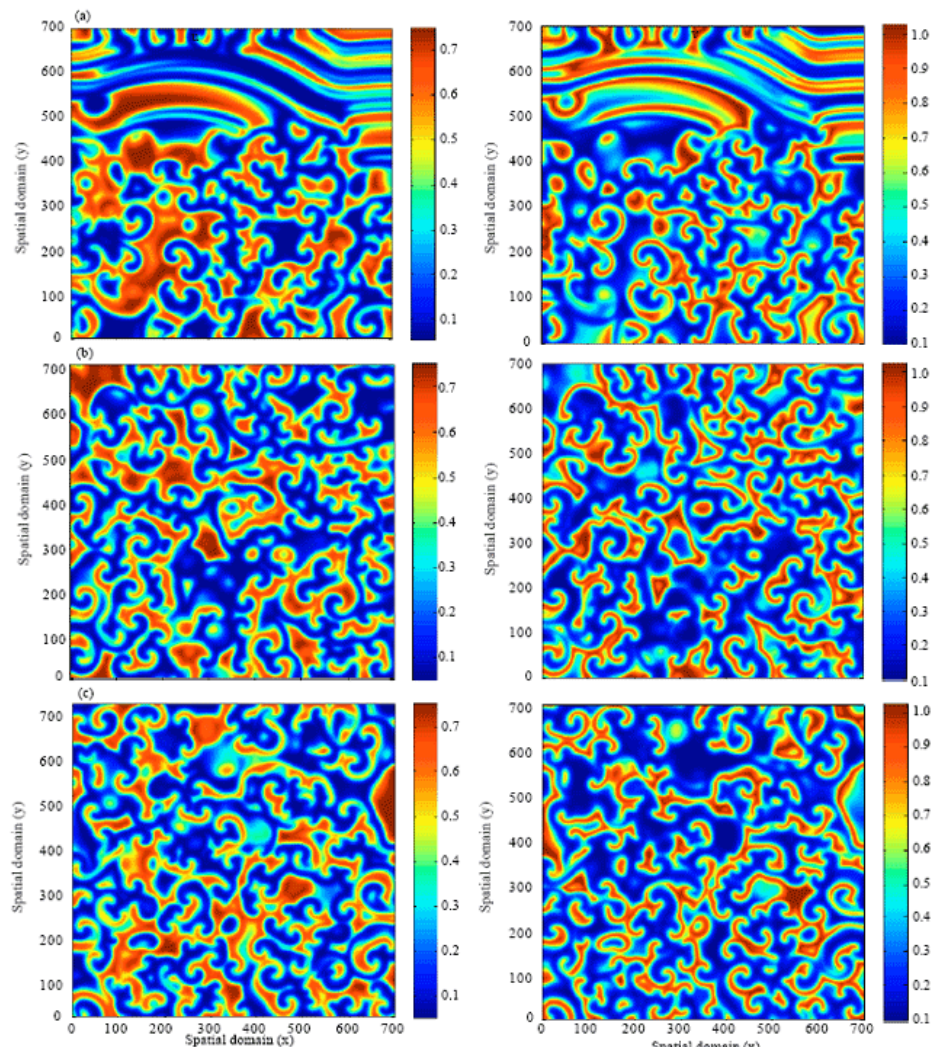
Figure 9. Chaotic patterns arising in the locally active and unstable region on the boundary of the edge of chaos region for different cell parameter sets.